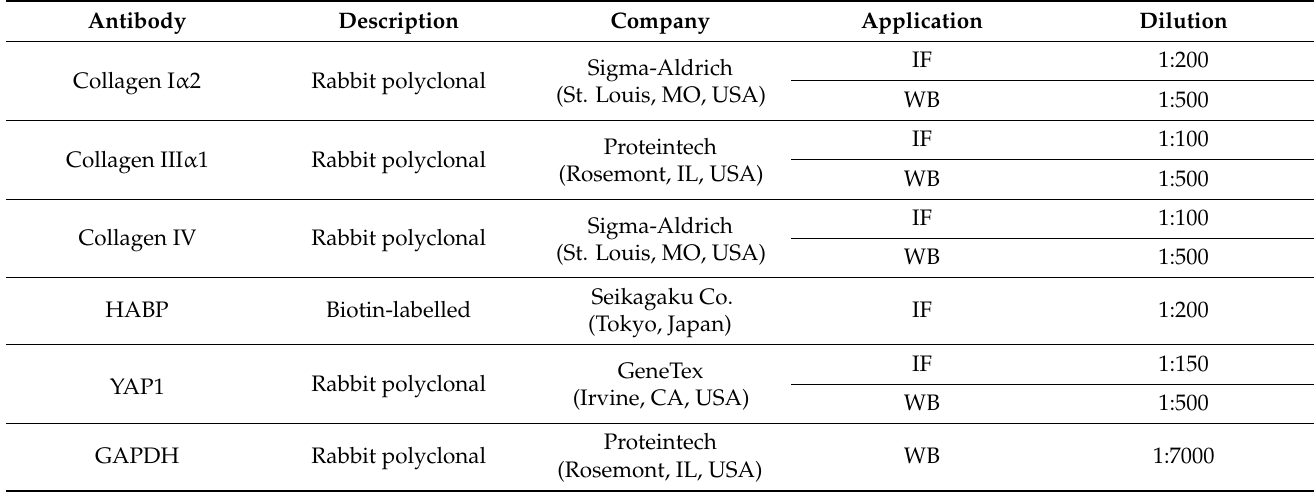
Table 1. List of primary antibodies used for immunocytochemical (IF) and immunoblotting (WB)